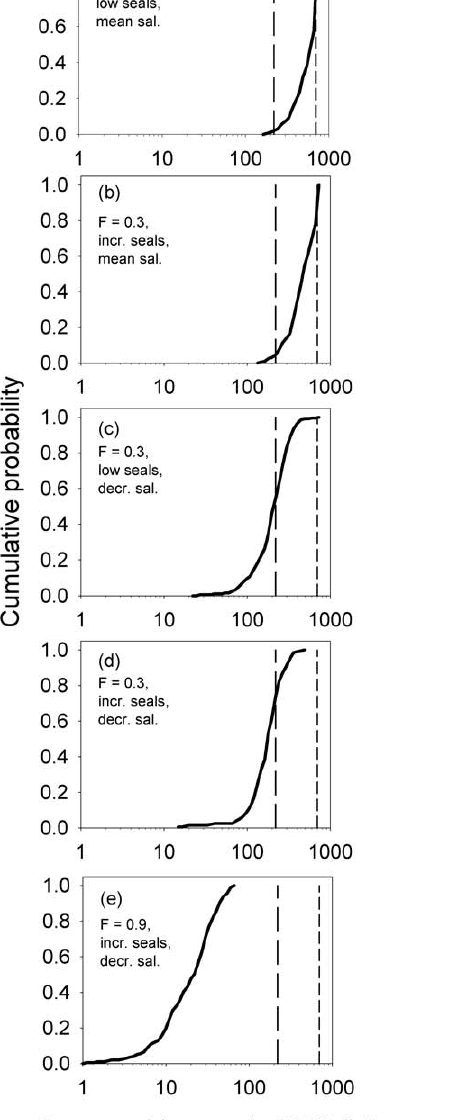
Figure 4. Cumulative probability of cod spawner biomass in the eastern Baltic Sea in 2089. Different panels show outputs for different combinations of forcings (exploitation, seal predation, climate change induced salinity decline) as derived from 200 stochastic simulations of an age-structured population model. The vertical long- dashed and short-dashed lines represent respectively the long-term mean and maximum spawner biomass during 1925–2008 [23]. See Methods and Table 1 for modelling details.